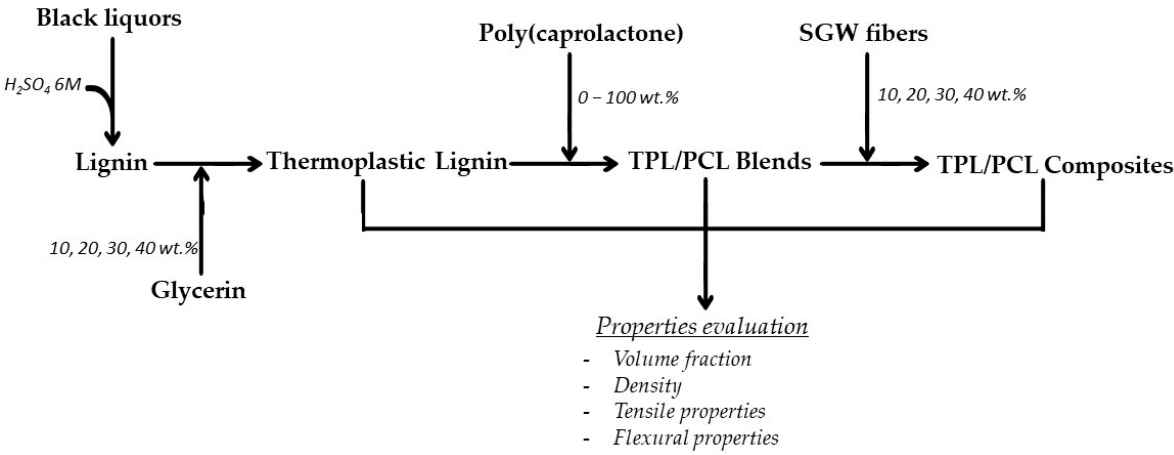
Figure 1. Flowchart diagram of the experimental procedure.